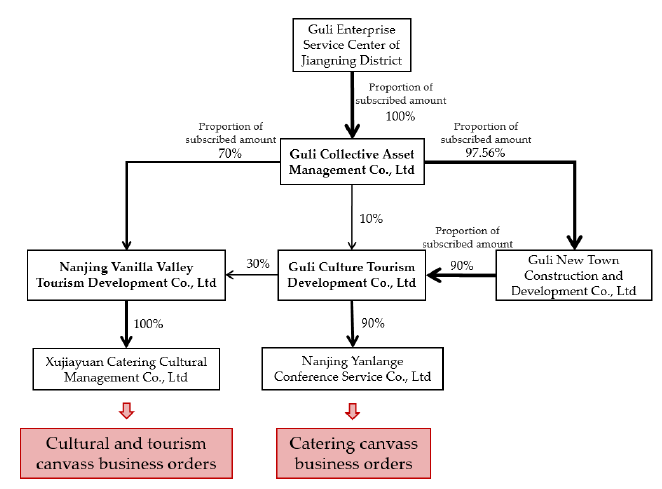
Figure 5. Collective asset management and construction platform for the Guli Subdistrict.